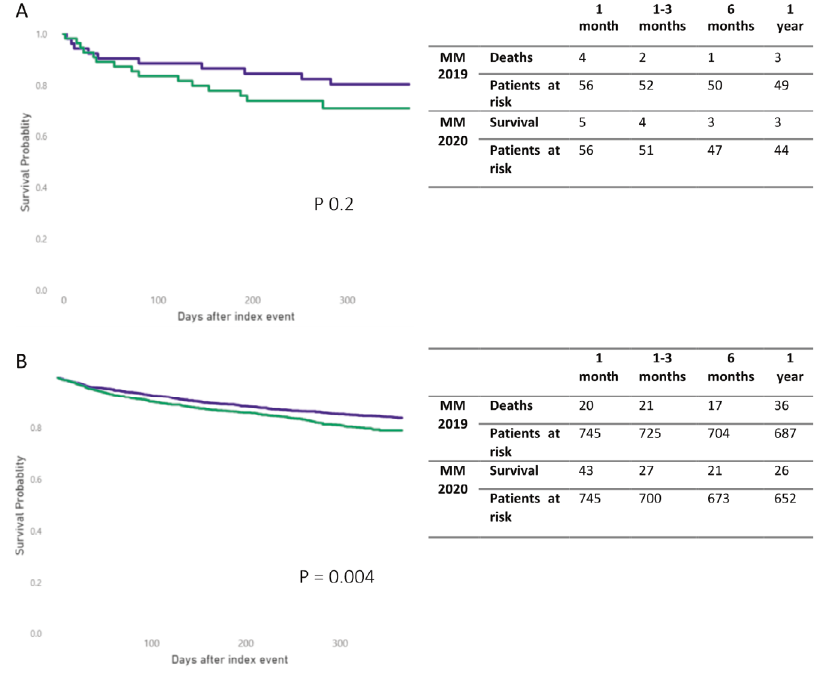
Fig. 3 MM survival by year. A KM plots comparing OS after the fi rst year of MM diagnosis of patients diagnosed in 2019 (purple) and in 2020 (green), with H12O data. B KM plots comparing OS after the fi rst year of MM diagnosis of patients diagnosed in 2019 (purple) and in 2020 (green), with EMEA